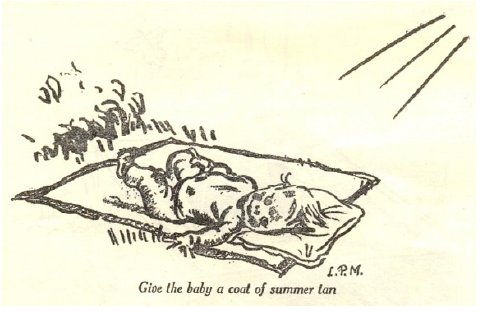
Figure 23. A Summer Tan for Baby. While recommendations for outdoor naps and open windows in the winter had moderated by the mid-20th century, fresh air and sunshine were encouraged, but with a caveat about “too much sun” (see Figure 24) found in Your Baby’s First Year (U.S. Department of Health, Education, and Welfare, Children’s Bureau 1962).